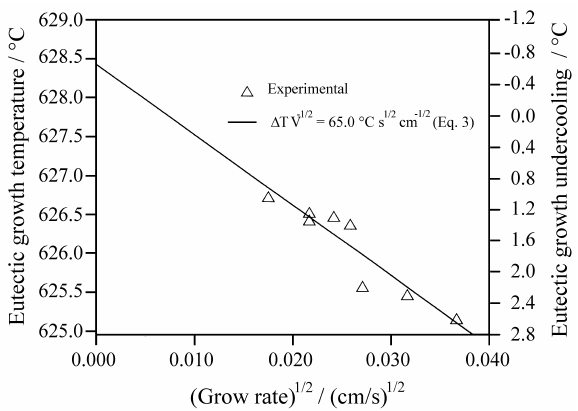
Figure 5. Variation of the eutectic growth temperature with the square root of the growth